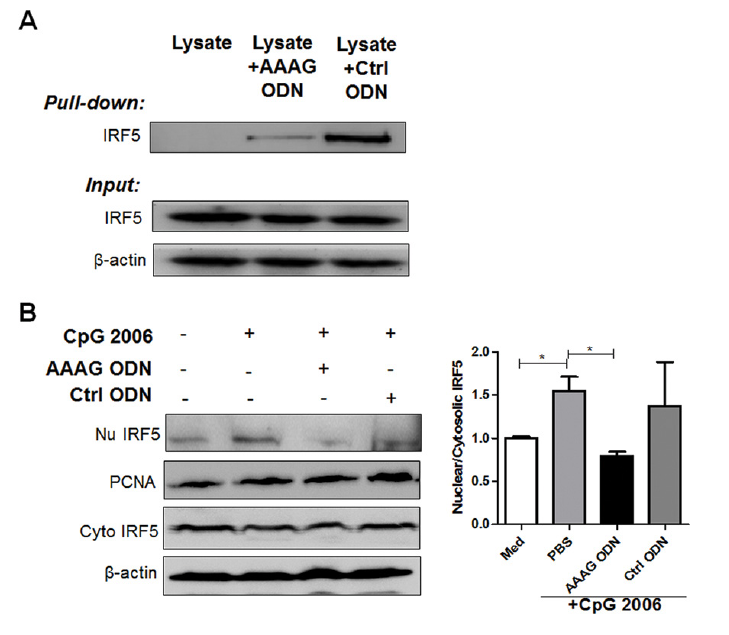
Figure 6. The interfering role of AAAG ODN on IRF5. (A) Binding of AAAG ODN with IRF5. The proteins in IRF5 expressing HEK293 cells were pulled down using AAAG ODN or control ODN-coated beads, and analyzed by Western blot with IRF5 monoclonal antibodies. (B) Inhibition of AAAG ODN on nuclear translocation of IRF5. The THP-1 cells were incubated with CpG 2006 plus AAAG ODN or control ODN for 24 h, then harvested to separate cytoplasmic and nuclear fractions. The proteins in each fraction were recognized by IRF5 antibodies by Western blot. Nu IRF5: IRF5 in nucleus; Cyto IRF5: IRF5 in cytoplasm. The data are from three independent experiments and are represented as mean ±